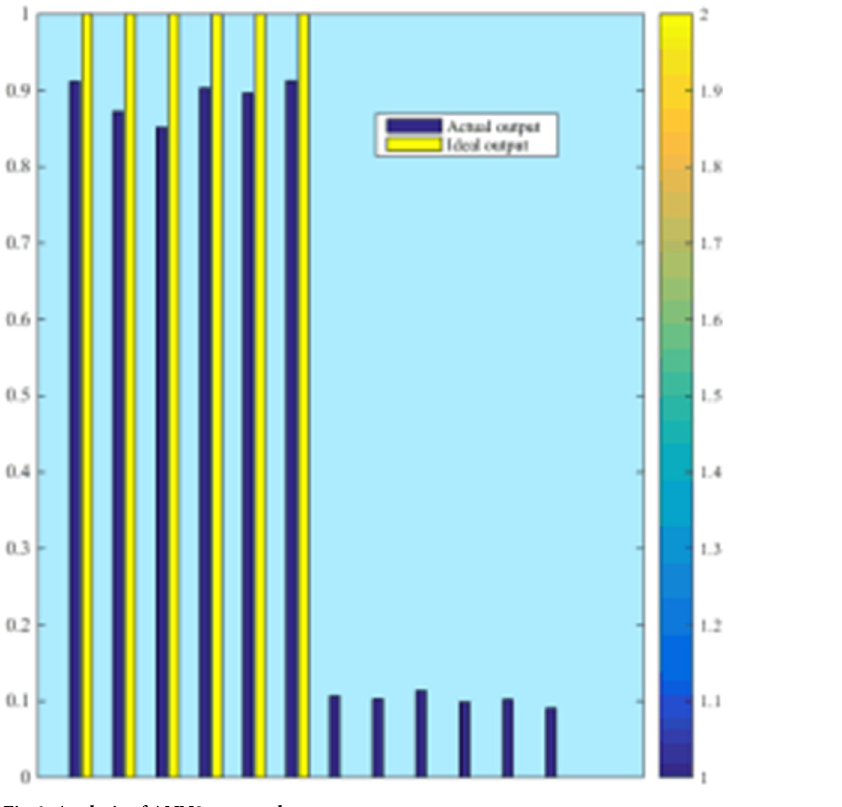
Fig 6. Analysis of ANN3 test